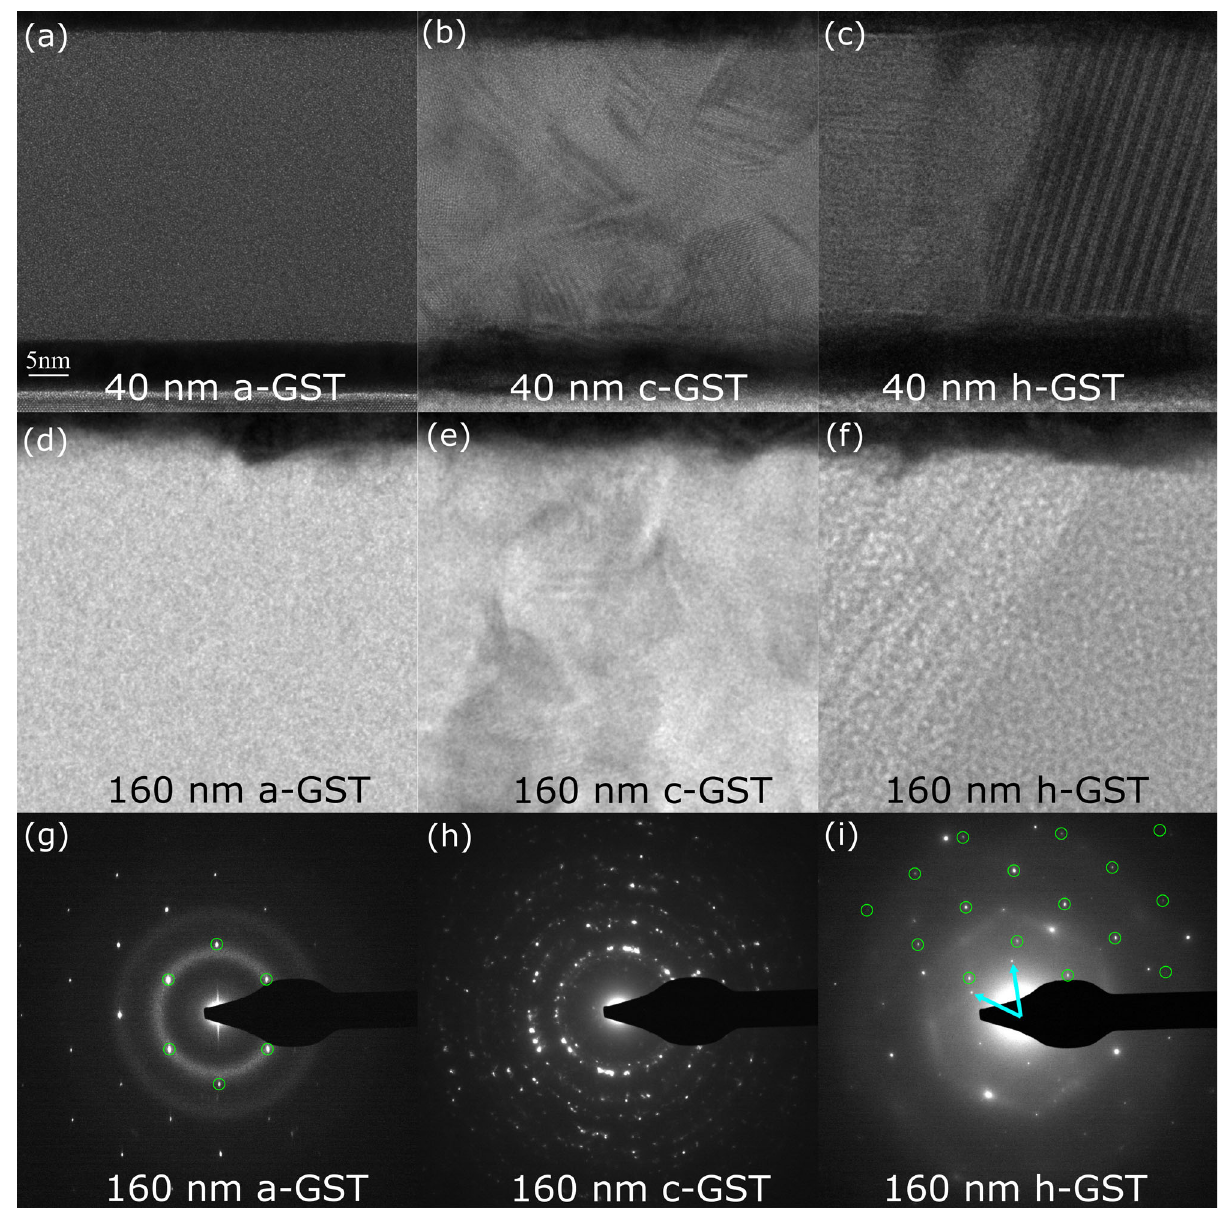
Fig. 2 Transmission electron microscopy of different GST phases. Bright- fi eld images of the: a – c 40 nm and d – f 160 nm GST thin fi lms at: a , d 25 °C, b , e 240 °C and c , f 400 °C, showing a sequence of phase transformations from amorphous to cubic to hexagonal GST, respectively. Selected area diffraction patterns (SADP) of the 160 nm fi lm at: g 25, h 240, and i 400 °C, re fl ecting the phase transformations and microstructures observed in the BF images. In the inner ring of g and the top half of i , the green circles indicate Bragg spots in the [110] zone axis of the Si substrate, and blue arrows in i show {100} primitive reciprocal-lattice vectors of h-GST in a [001] zone axis. Diffuse streaks in i extending through the {210} Bragg spots are due to the transnational shear faults seen in c and f